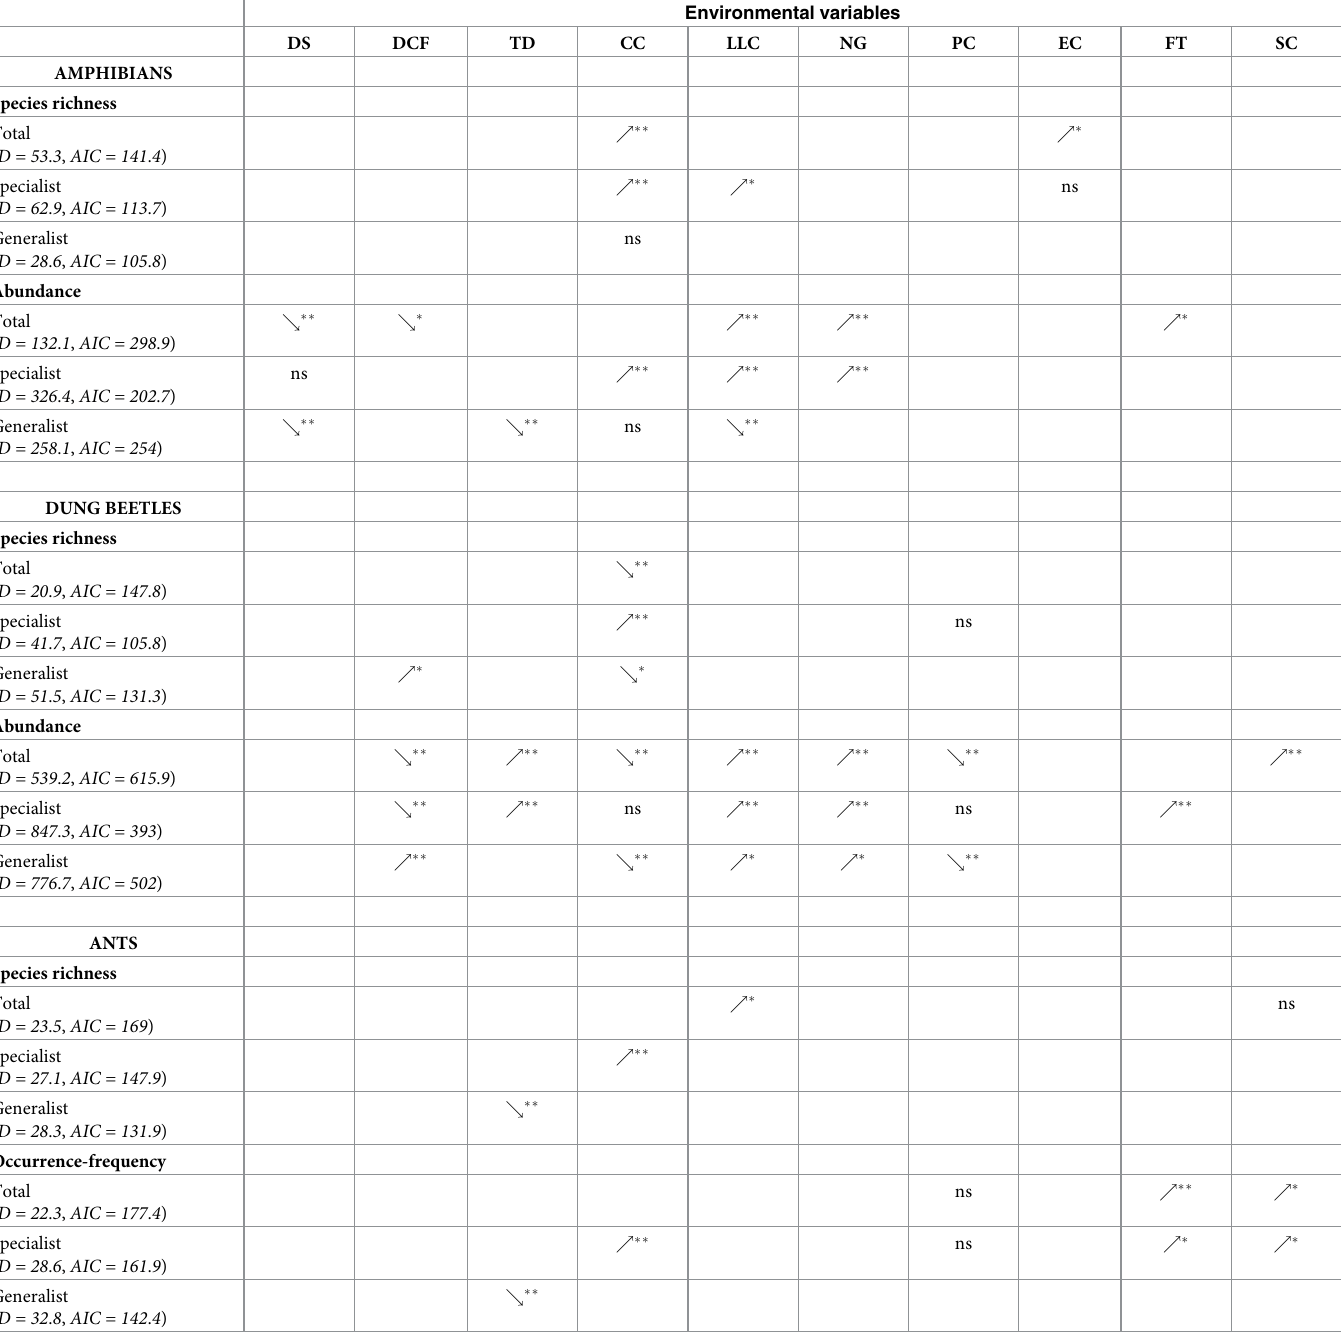
Table 1. Results of the generalized linear models ( Δ AICc � 2) that best explain species richness, abundance or occurrence-frequency per plot of amphibians, dung beetles and ants ( D = deviance, AIC = Akaike Information